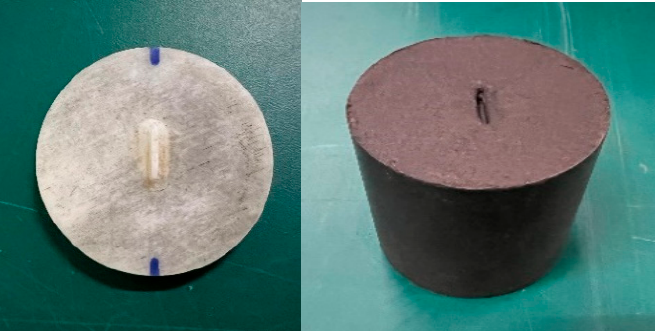
Figure 5. Plastic mold and biochar–methanotroph–clay mixture compaction sample.